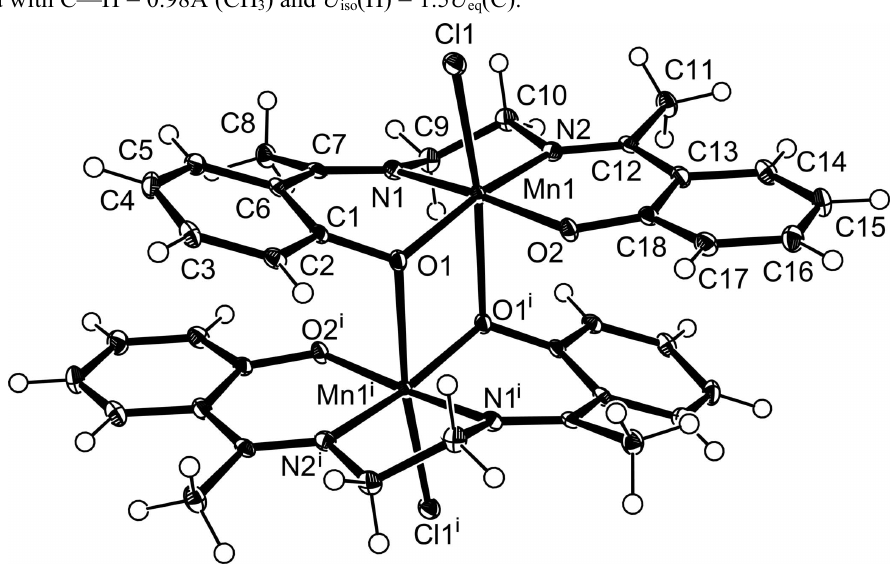
Molecular structure of the title compound. Displacement ellipsoids are drawn at the 50% probability level. [Symmetry code: (i) - x , 2 - y , - z